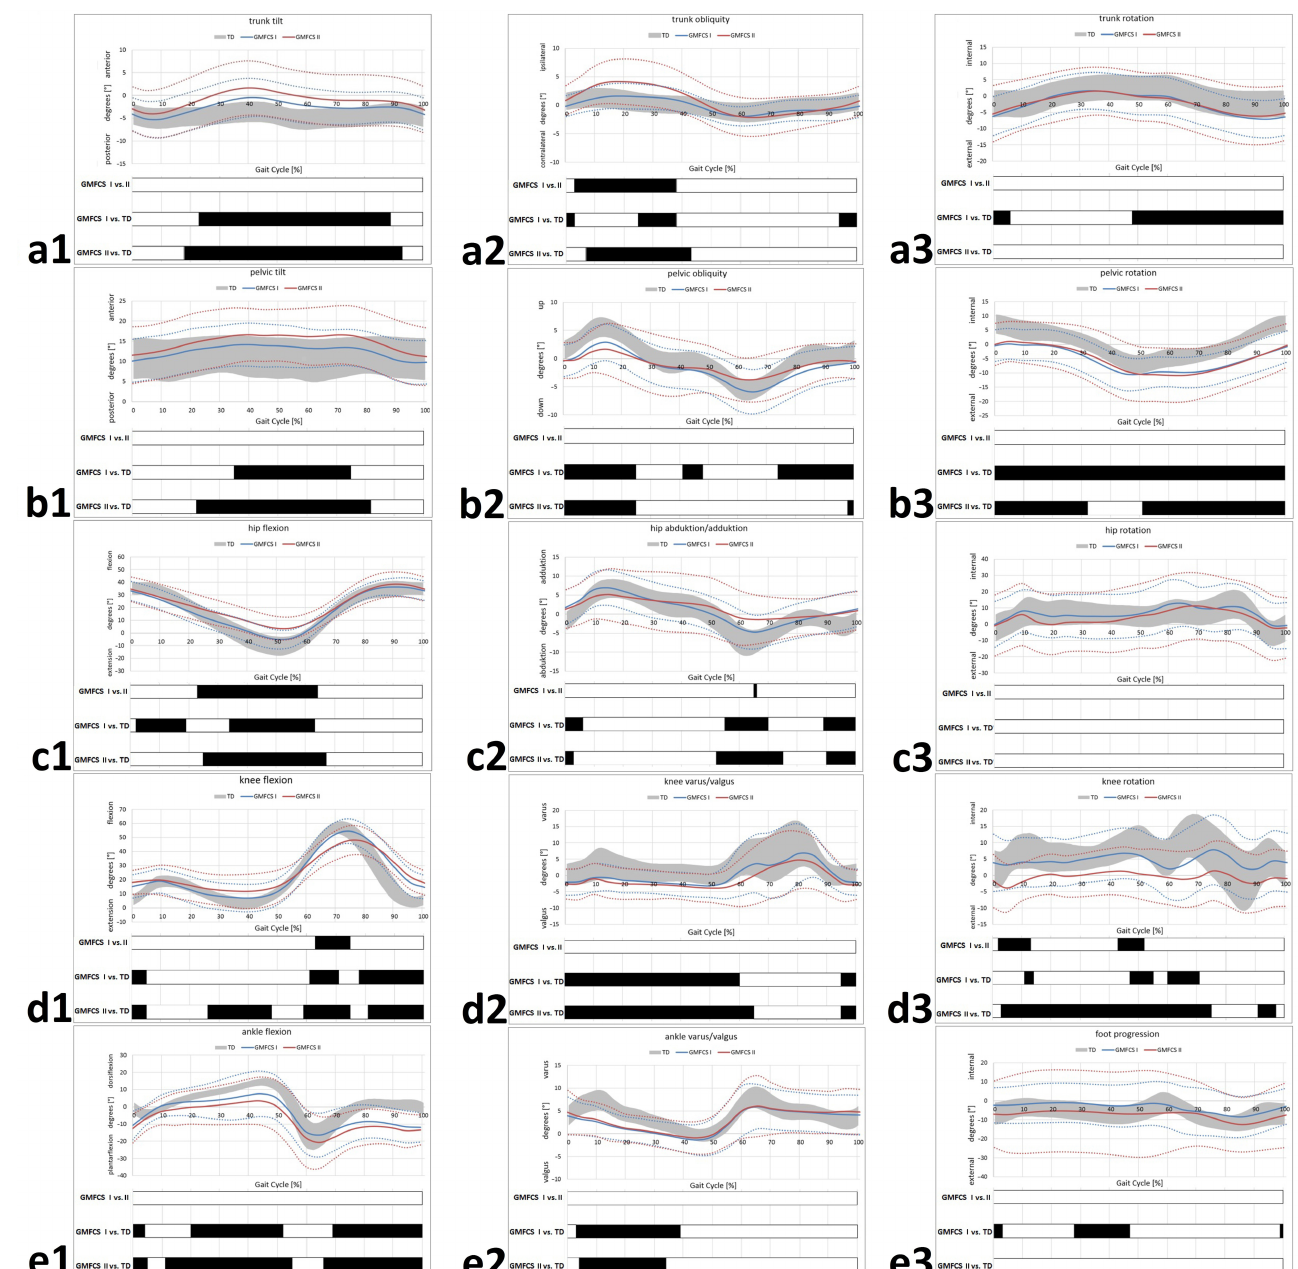
Figure 1. GMFCS level-specific kinematics. Trunk kinematics ( a1 – a3 ); pelvic kinematics ( b1 – b3 ); hip kinematics ( c1 – c3 ); knee kinematics ( d1 – d3 ); ankle/foot kinematics ( e1 – e3 ). TD group (age-matched typically developing individuals) of the gait laboratory data base. Black bars represent the results for SPM (statistical parametric mapping) and indicate periods of significant differences throughout of the gait cycle. Straight lines represent the mean of the involved limb of the participants with cerebral palsy (CP). Dotted lines indicate a range of ± 1 standard deviation